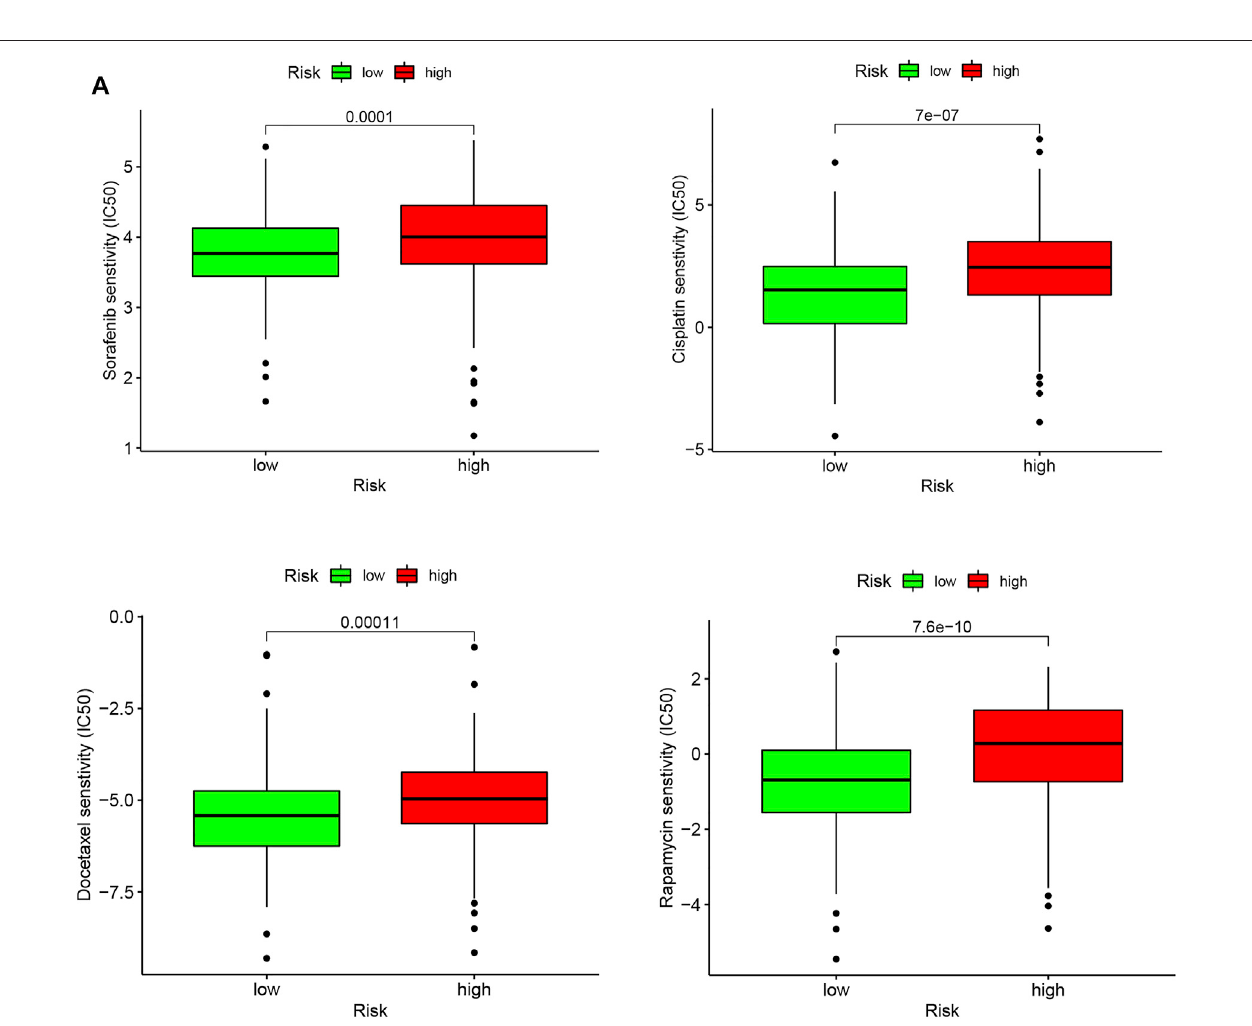
FIGURE10| Chemotherapeuticresponseinthe high-risk and low-risk groups. (A) Box plotvisualizingthe IC50 ofSorafenib, Cisplatin,Docetaxel,and Rapamycin between low- and high-risk HCC